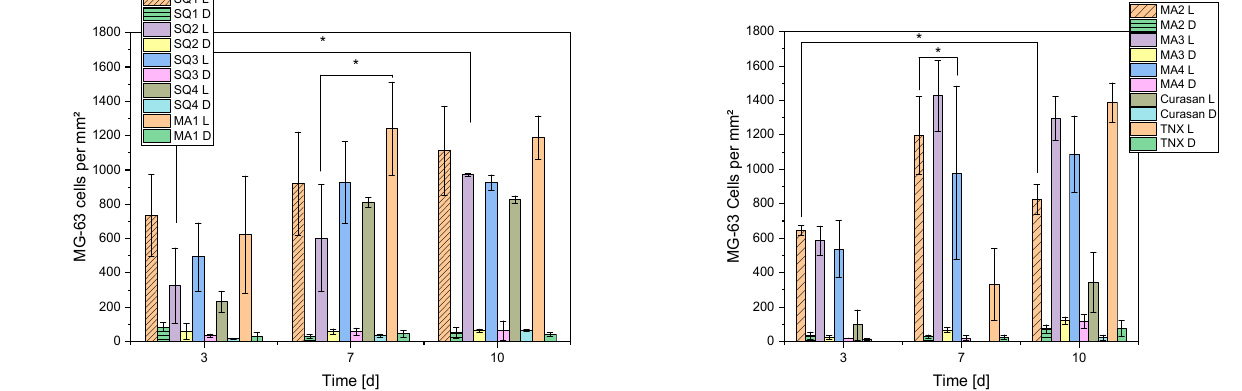
Figure 9. Living and dead cells per mm 2 for the different compositions. Due to the high number of samples, the presentation was divided into 2 diagrams. L corresponds to living and D to dead cells, TNX is the 2D control on Thermanox cover slips and Curasan the 3D control on ceramics. [*] represents significant difference with p < 0.05 (ANOVA).